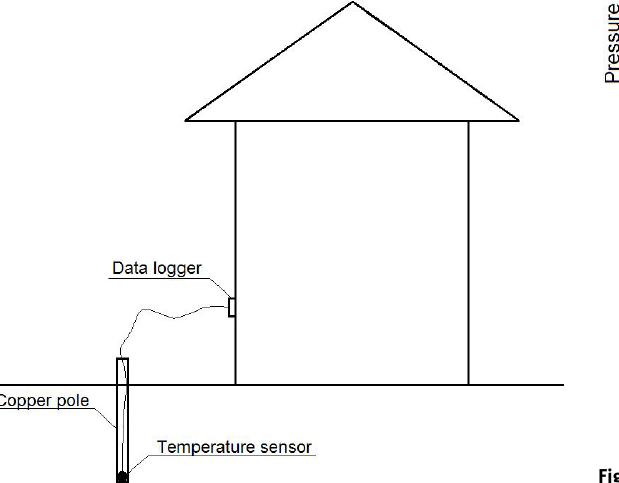
Figure 2: FTemperature analysis station model.